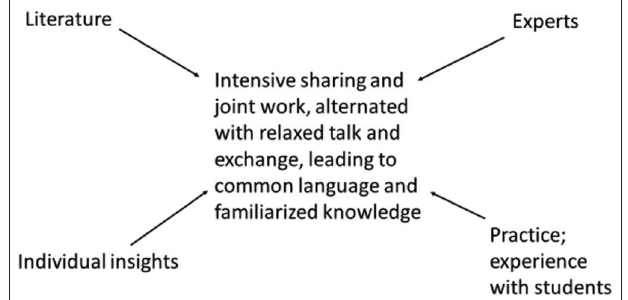
FIGURE 1 | “Familiarized knowledge” as an outcome of the Learning